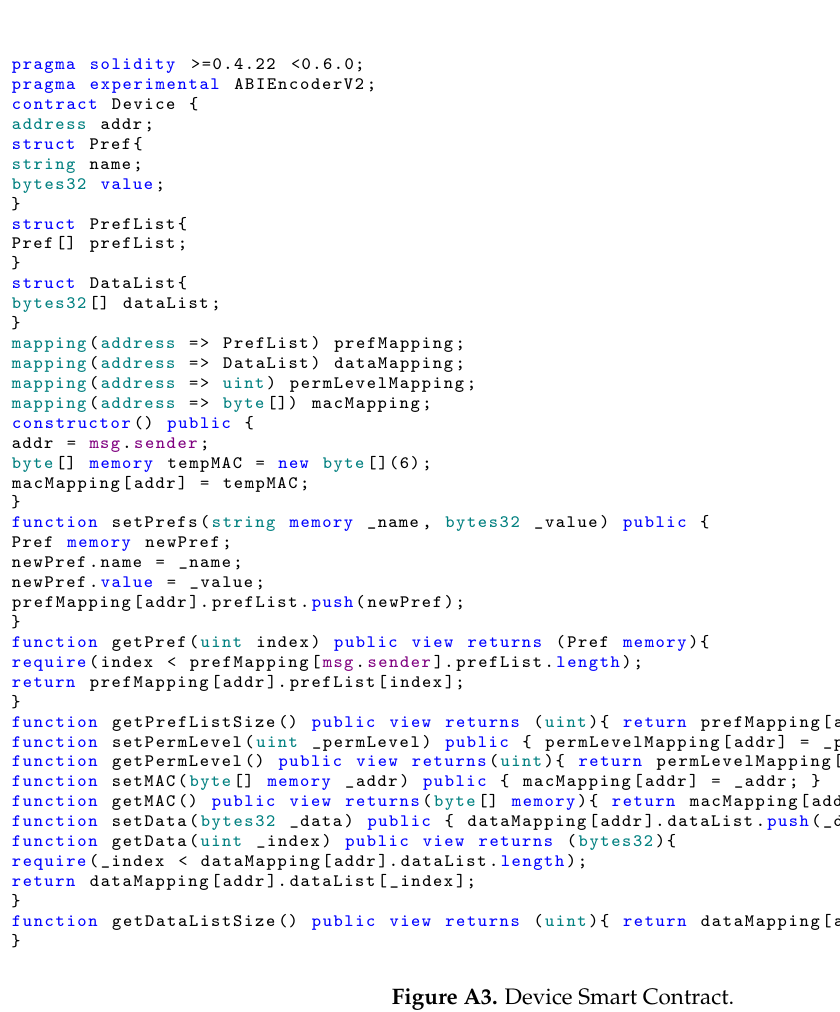
Figure A3. Device Smart